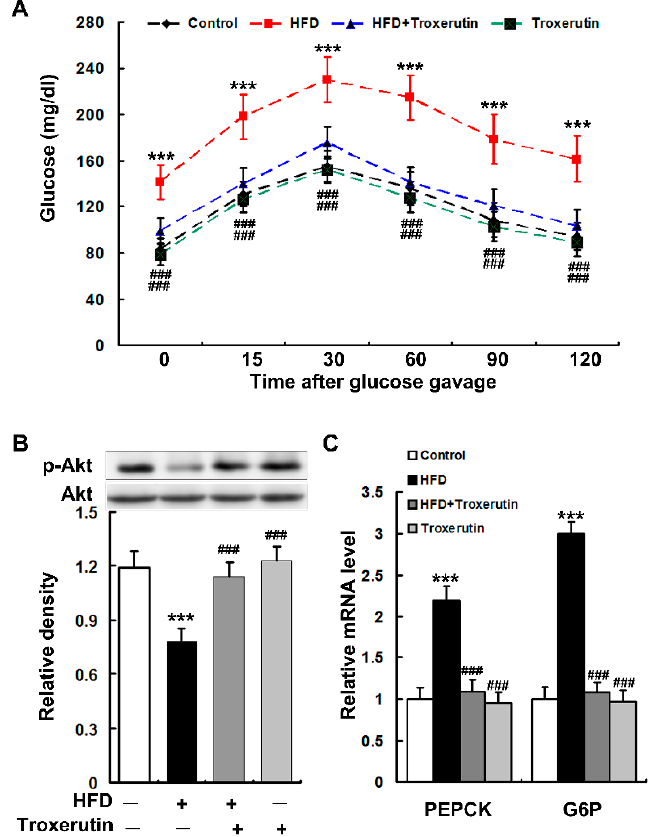
Figure 2. Troxerutin attenuates hepatic gluconeogenesis in HFD-treated mice. ( A ) Data of glucose tolerance tests in different treatment groups. ( n = 5); ( B ) Immunoblotting and densitometry of p-Akt (serine 473) in mouse livers ( n = 3); ( C ) The mRNA levels of gluconeogenic genes in mouse livers ( n = 3). All of the values are expressed as the mean ± SD. *** p < 0.001 vs. the control group; ### p < 0.001 vs. the HFD group.